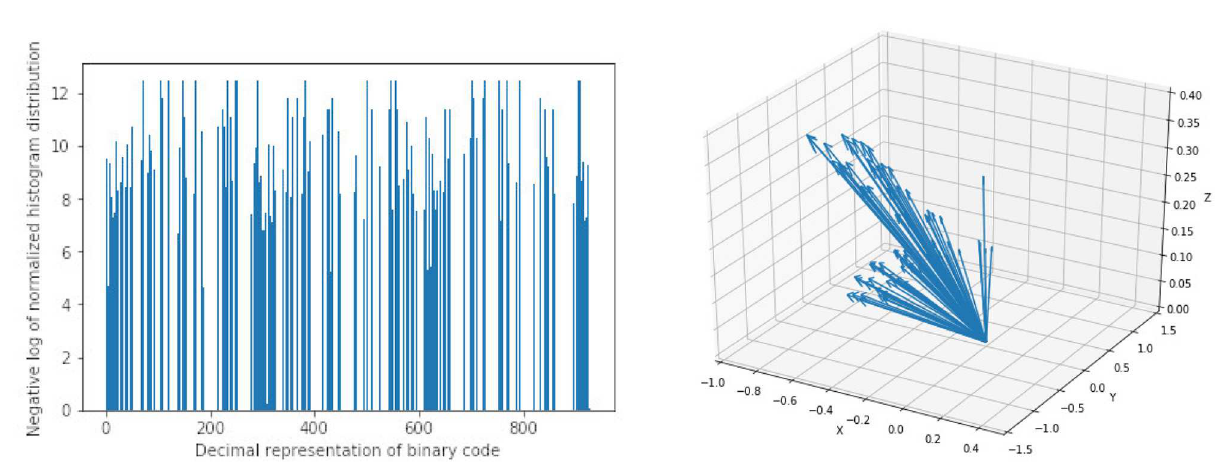
FIGURE6 Sample of extracted features using Local Binary Pattern (LBP) on the left and Histogram of Oriented Gradients (HOG) on the right . Bar heights from LBP features represent the frequency of a given pattern and the position on the x-axis is the decimal representation of the binary pattern. Arrow directions in HOG features are the gradient vectors and the length of the arrows represents the frequency of the given gradient. The LBP features show a uniform distribution of the extracted patterns with no dominant pattern. The HOG features on the other hand show evidence of high gradients in the extracted region of interest.